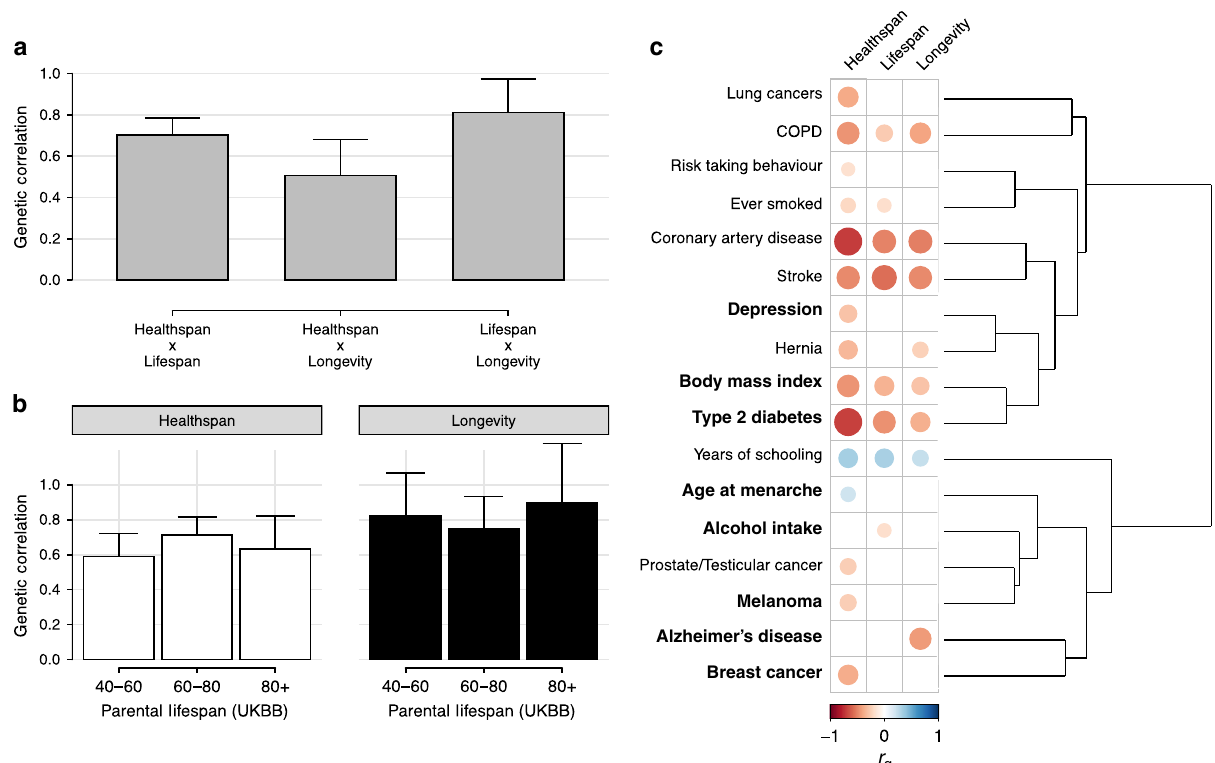
Fig. 1 Healthspan, parental lifespan, and longevity are highly genetically correlated. a Pairwise genetic correlation between human ageing studies. b Genetic correlations of age-strati fi ed parental lifespan against healthspan and longevity. c Genetic correlations ( r g ) of ageing traits with traits related to development, behaviour, and disease. In bold are traits with heterogeneous correlations ( P het < 0.05). Displayed here are 17 traits which have at least one signi fi cant (FDR < 5%) genetic correlation with healthspan, parental lifespan, or longevity, out of the 27 traits tested. The 17 traits are clustered by Euclidean distance based on their genetic correlation with all tested traits (30 in total). See Supplementary Data 1 for a full list of correlations and Supplementary Table 1 for the number of SNPs used to calculate each pairwise correlation. Blank squares represent correlations which did not pass multiple testing correction. Note that fewer correlations with longevity will pass this threshold due to the smaller sample size of this GWAS. Error bars represent 95% con fi dence intervals of the correlation estimates. COPD: chronic obstructive pulmonary disease.